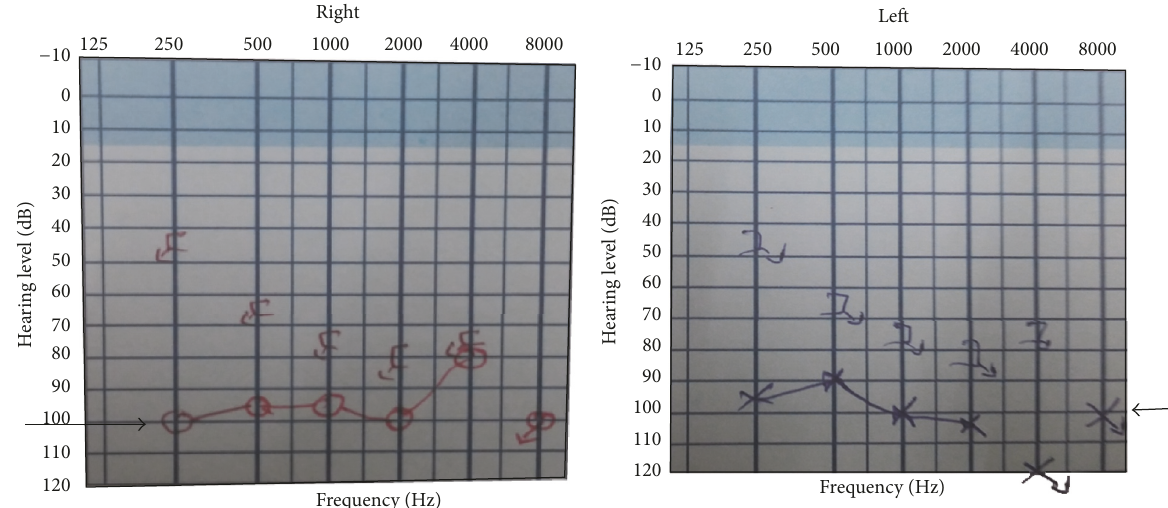
Figure 3: Pure tone audiometry showing bilateral sensorineural hearing